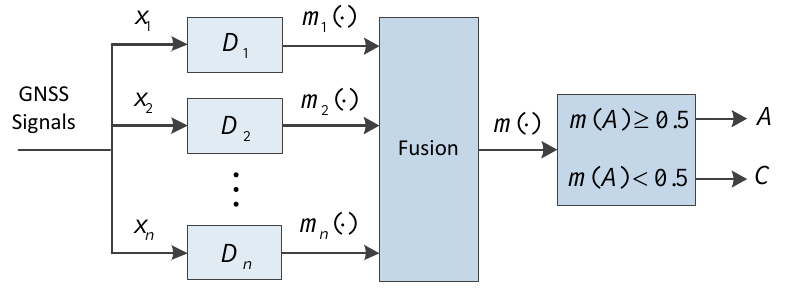
Figure 1. Diagram of the fusion of multiple spoofing detectors.